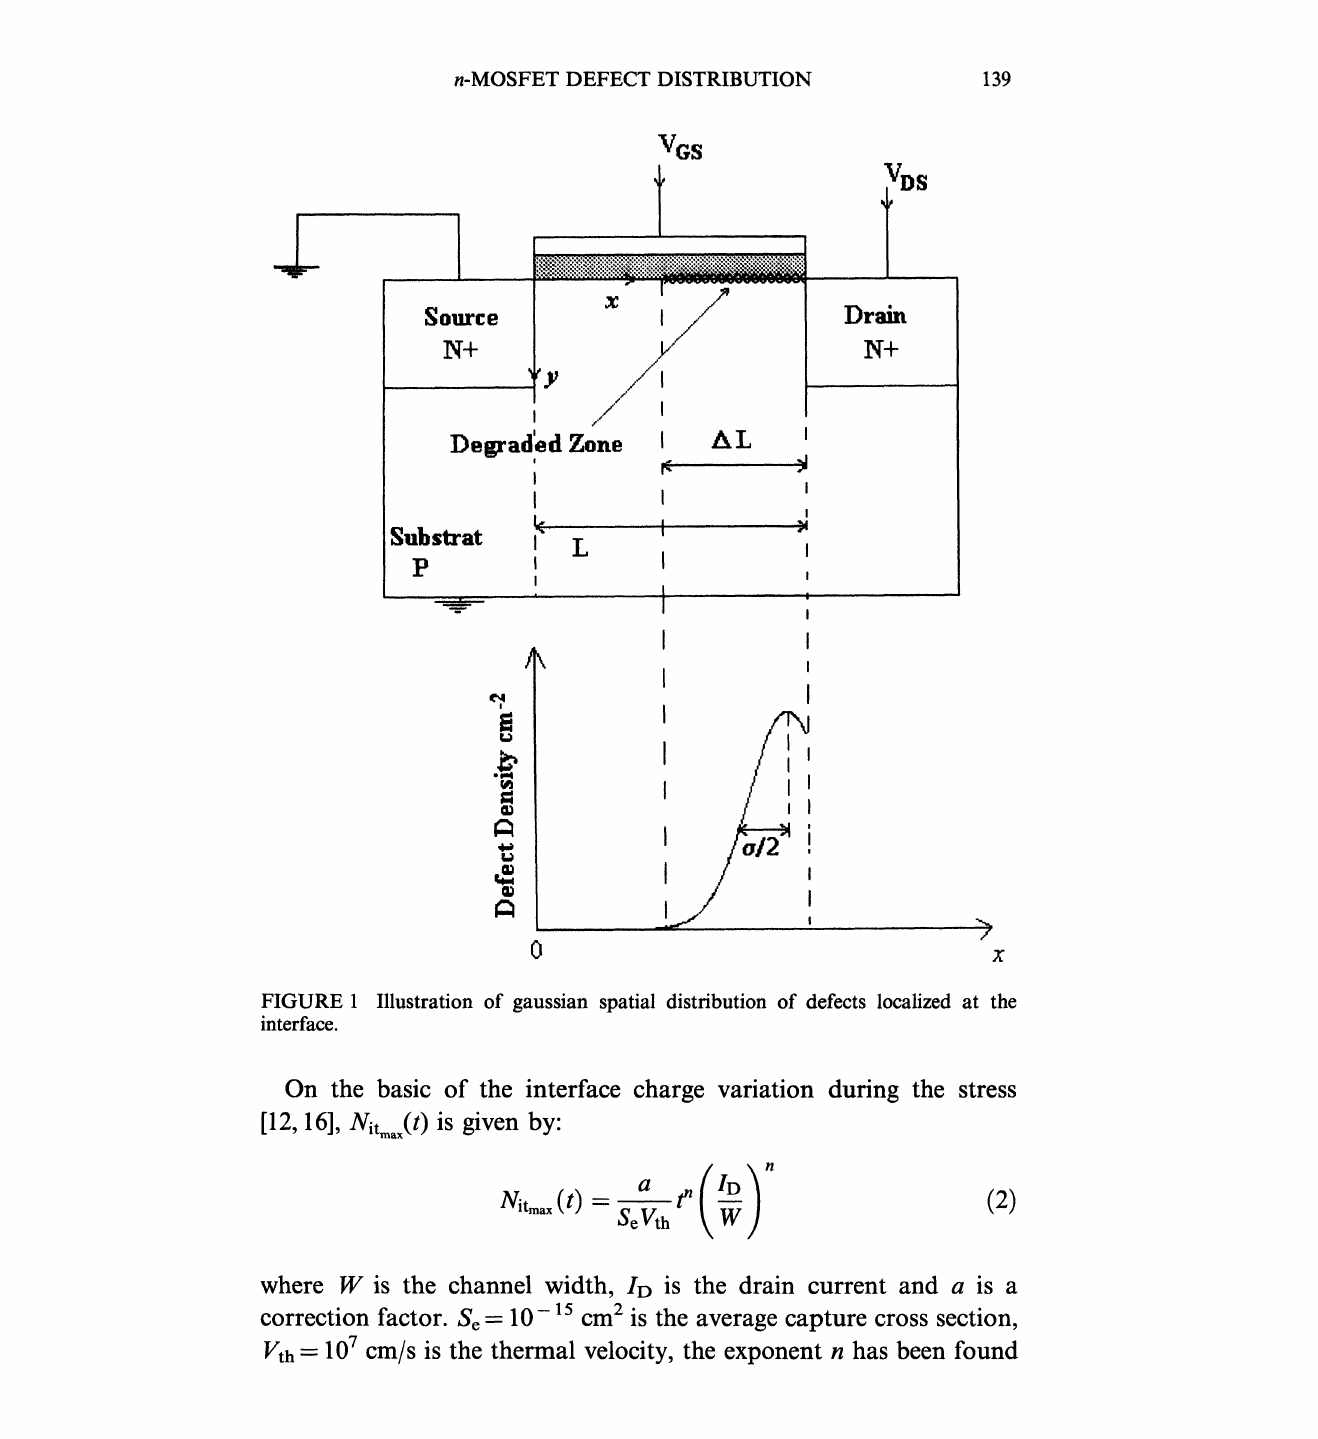
FIGURE Illustration of gaussian spatial distribution of defects localized at interface.